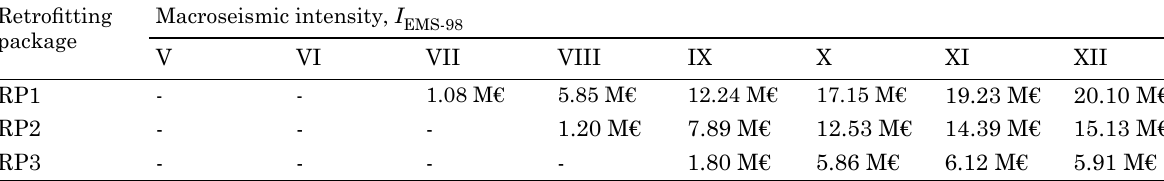
(in millions of €) i